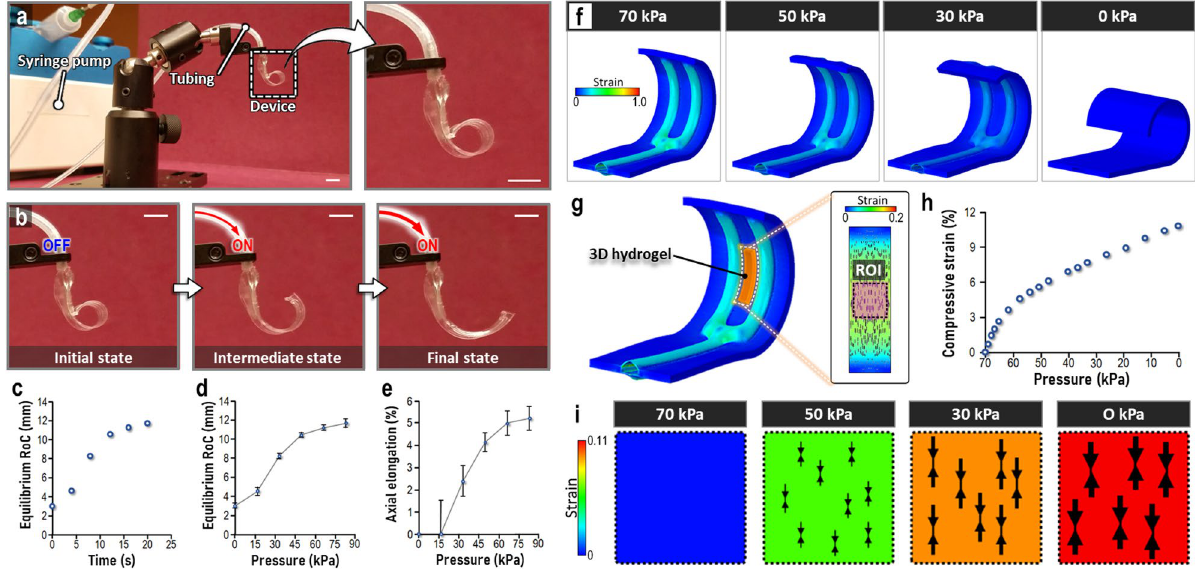
Figure 2. Pneumatic actuation of soft robotic constrictor. ( a ) Experimental setup for controlled pneumatical actuation of the soft robotic device. Scale bars, 5 mm. ( b ) Photographs of the uncoiling device due to applied air pressure. Scale bars, 5 mm. ( c ) Quantification of equilibrium RoC during the application of pneumatic pressure . Plots of equilibrium RoC ( d ) and axial elongation ( e ) at different levels of applied pneumatic pressure. ( f ) Finite element analysis-based computation prediction of substrate geometry and strain during pneumatic actuation of the soft robot. The heatmap shows maximum nominal principal strain. ( g ) Inclusion of 3D hydrogel for finite element modeling of 3D tissue. ( h,i ) In silico prediction of changes in mean compressive strain in the ROI with decreasing pneumatic pressure. The size of arrow pairs in ( i is proportional to the level of compressive strain. The heatmap shows maximum nominal principal compressive strain. Data show mean ± SD with n =